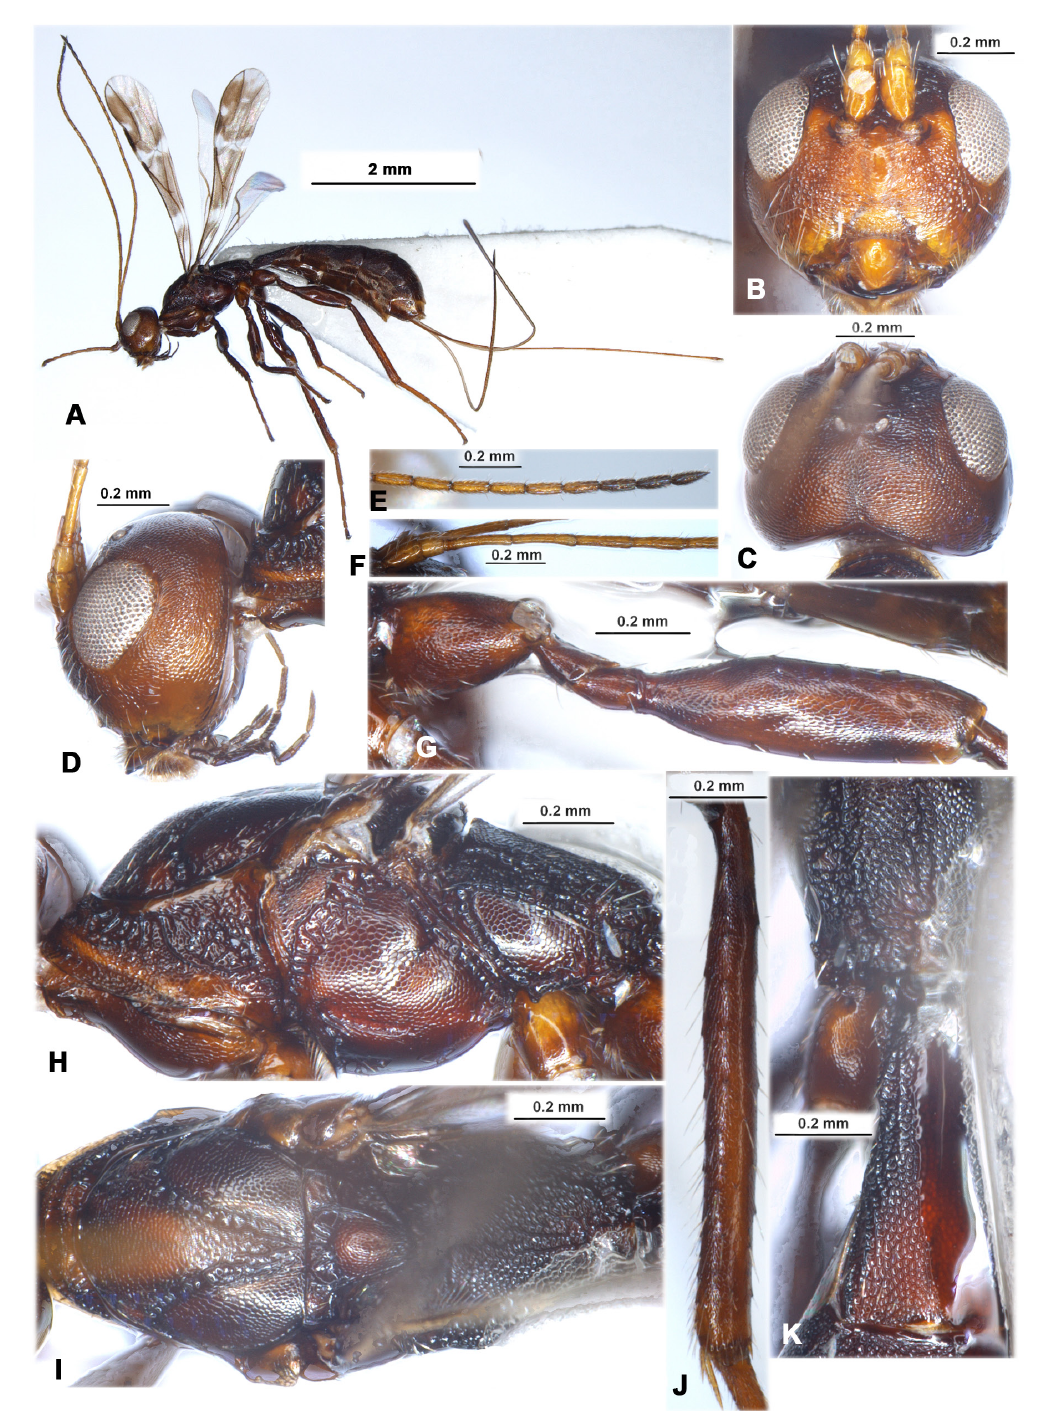
Fig. 41. Platyspathius ( P. ) longicaudis Belokobylskij sp. nov., holotype, ♀ (RMNH). A . Habitus, lateral view. B . Head, front view. C . Head, dorsal view. D . Head, lateral view. E . Apical segments of antenna. F . Basal segments of antenna. G . Hind leg. H . Mesosoma, lateral view. I . Mesosoma, dorsal view. J . Hind tibia. K . Propodeum and first metasomal tergite, dorsal